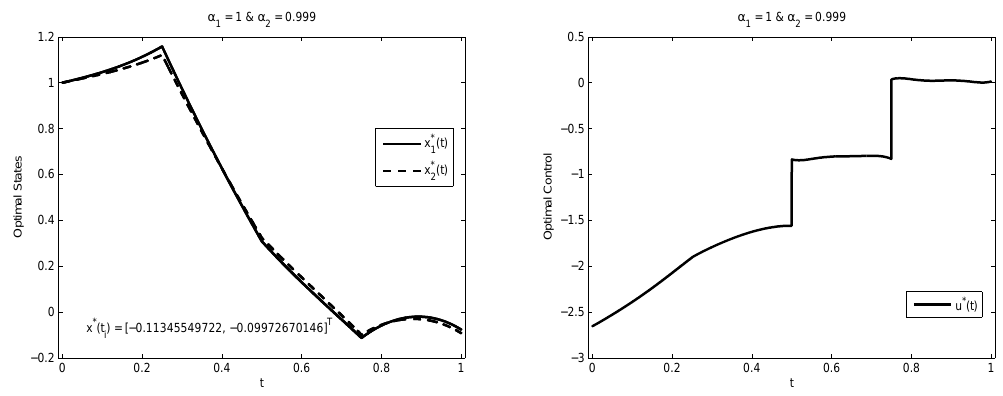
Figure 4. x ∗ ( t ) and u ∗ ( t ) for Case 2 with the interior point constraint, Example